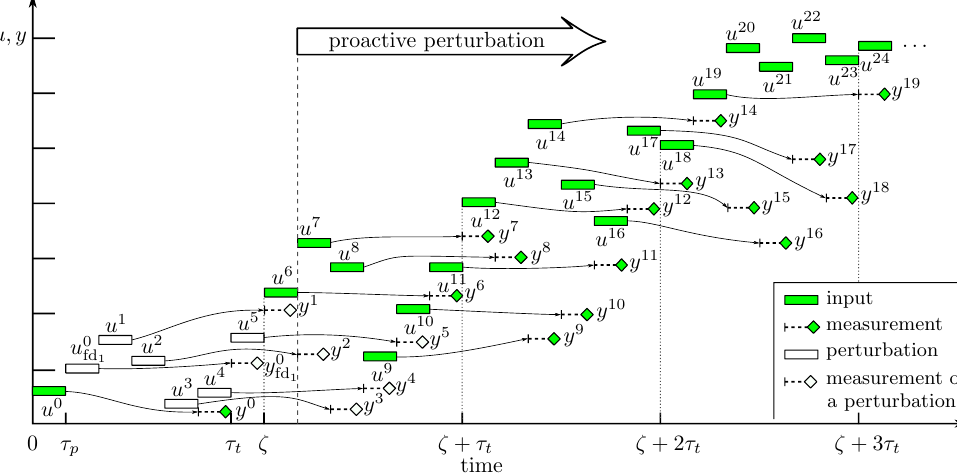
Figure 5. Illustration of proactive perturbation scheme for